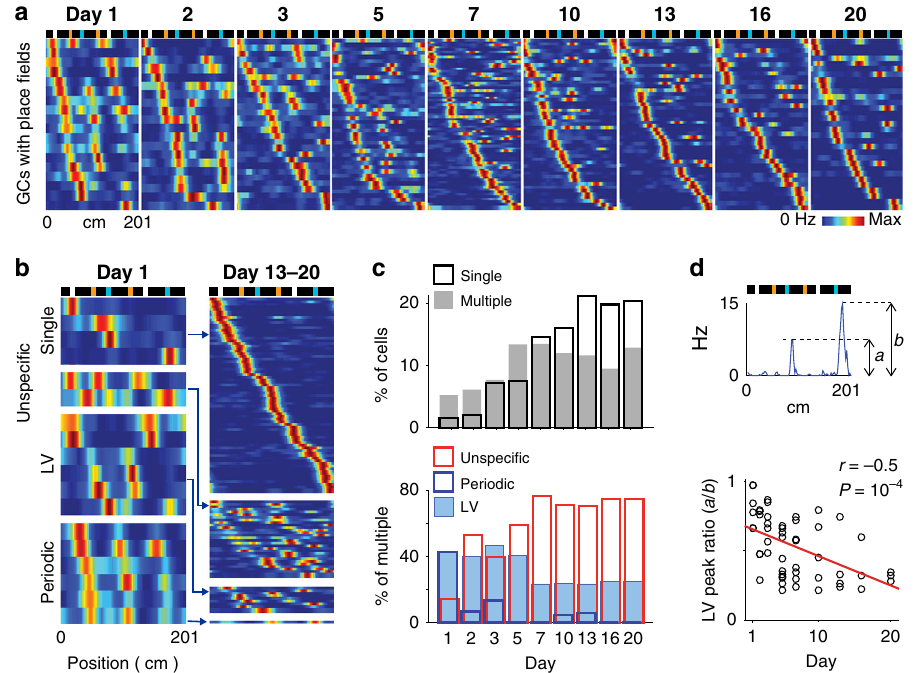
Fig. 3 Progressive transformation of GC fi ring fi elds across days. a Color-coded, fi ring rate maps of GCs across days. Only the GCs showing fi ring fi elds are displayed for clarity. The rows of the matrices correspond to individual GCs and are sorted according to fi ring fi eld positions. Top, scheme of the belt. b Color-coded, fi ring rate maps of GCs on day 1 (left) and on days 13, 16, and 20 combined (right), for each type of GC fi ring fi eld. The color scale is the same as that used in ( a ). c Upper, proportion of GCs with a single fi eld (black) and multiple fi elds (gray) across days. Lower, proportion of LV (light blue), periodic (dark blue) and unspeci fi c GCs (red), among multiple- fi eld GCs, across days. d Upper, de fi nition of LV peak ratio as the ratio between LV fi elds ’ peak fi ring rates (smaller peak over larger peak). Lower, distribution of LV peak ratios across days. Each dot is the LV peak ratio of one LV cell. Red line, linear fi t. n = 53, r = − 0.5, p = 1e − 4 , Pearson ’ s correlation, two-tailed t